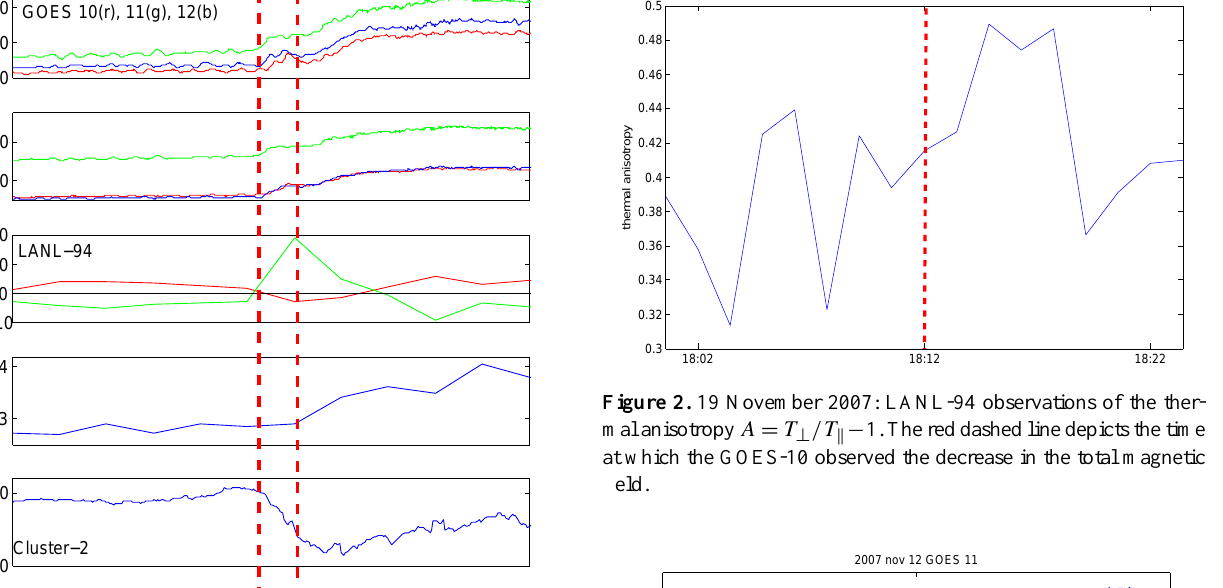
Fig. 2. 19 November 2007: LANL-94 observations of the thermal anisotropy A = T ⊥ /T k -1. The red dashed line depict the time when the GOES-10 observed the decrease in the total magnetic field. Figure 3. 12 November 2007: GOES-11 observations at 13.4MLT: the total magnetic field B t [nT] and z component of the magnetic field B z [nT] in the GSM coordinate